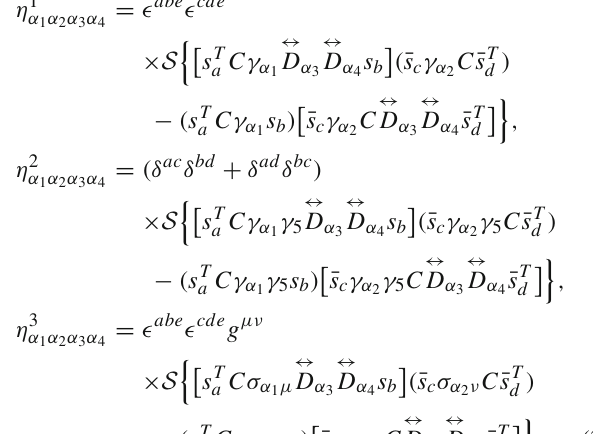
Fig. 1 Two configurations for the fully-strange tetraquark states: a the diquark–antidiquark system with the internal orbital angular momenta l λ / l ρ / l ρ (cid:2) and b the meson–meson system with l (cid:2) λ / l (cid:2) ρ / l (cid:2) ρ